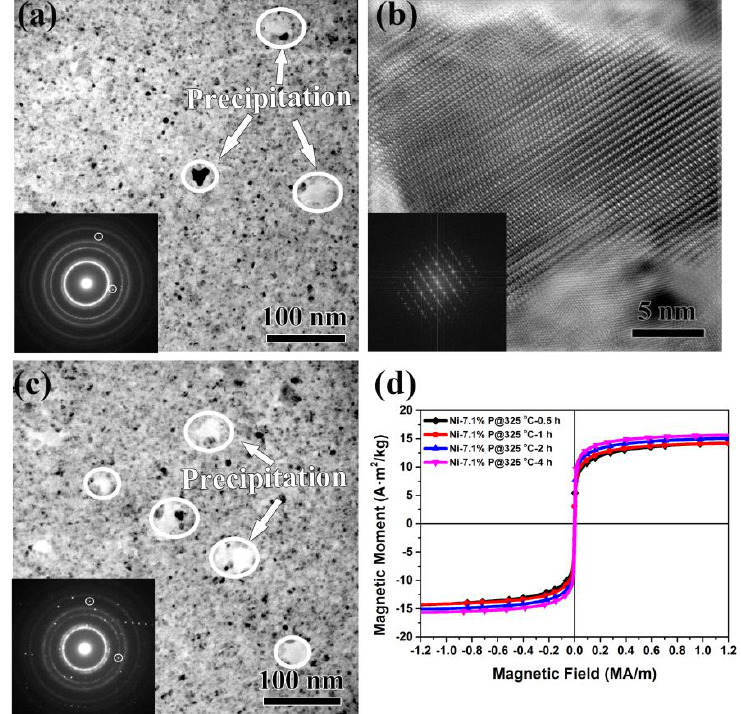
Figure 3. TEM images of Ni-7.1% P after annealing at 325 °C for ( a ) 2 h and ( c ) 4 h; ( b ) HRTEM of Ni 3 P. ( d ) The magnetic hysteresis loop curves of Ni-7.1%P annealed for different times. Insets are the corresponding SADPs. The white circles show the diffraction spots of Ni 3 P phase.